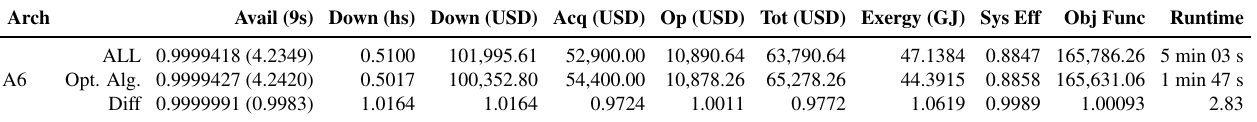
Comparing optimal results (ALL) with optimization algorithm (Opt. Alg.)